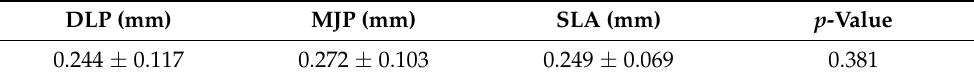
Table 5. The accuracy (precision by RMS value (mean ± SD) mm) of 3D-printed models ( n = 30).